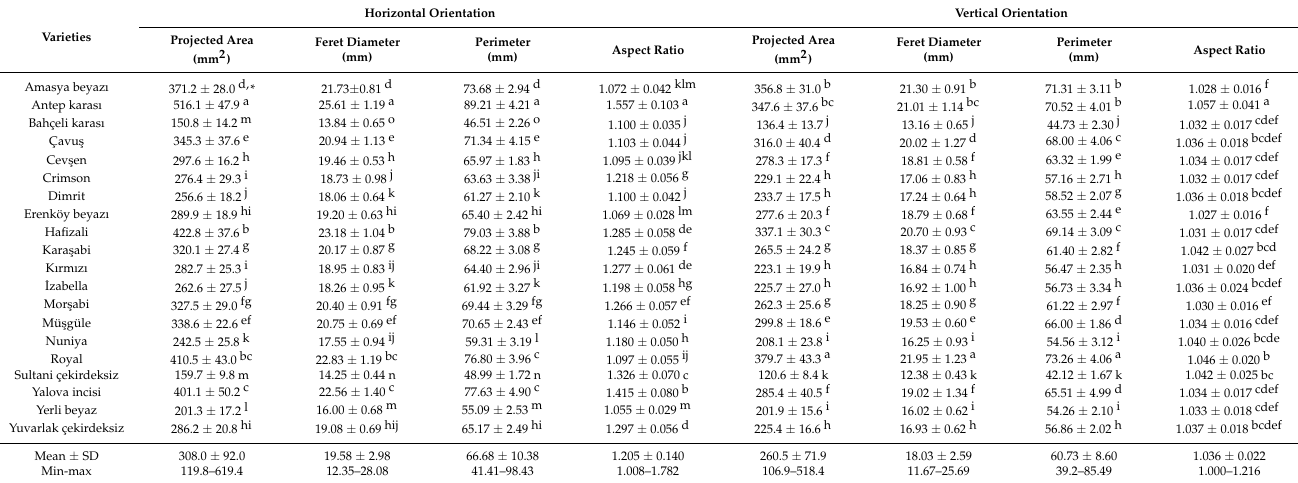
Table 3. Basic morphology and dimensional attributes measured at horizontal and vertical orientations.